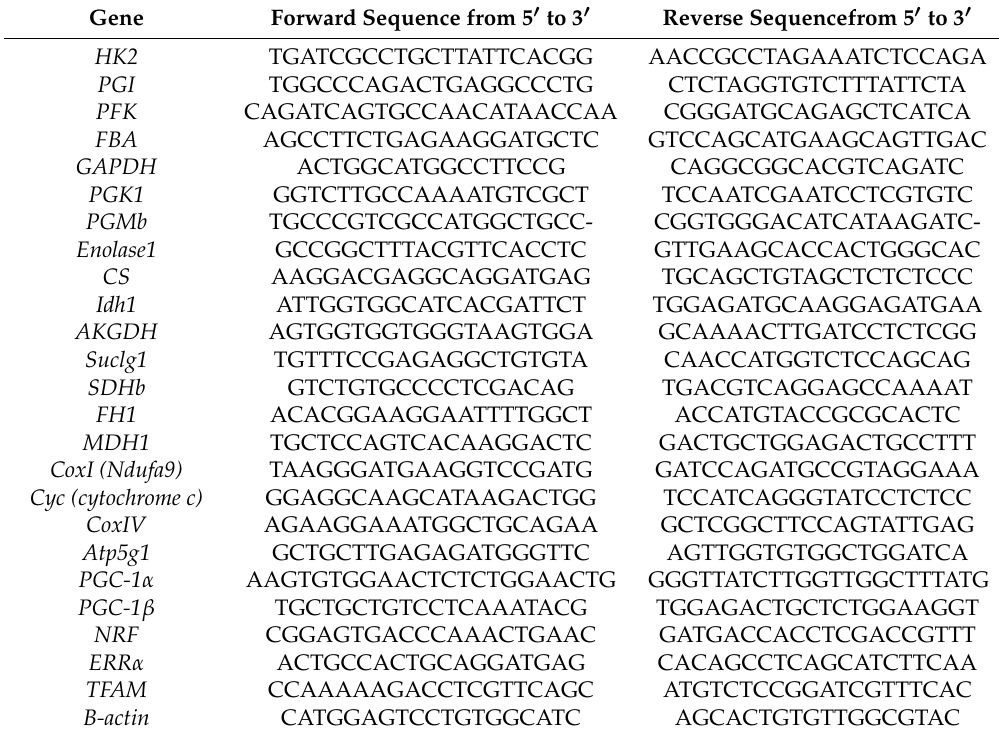
Table 2. Mouse primers for real time